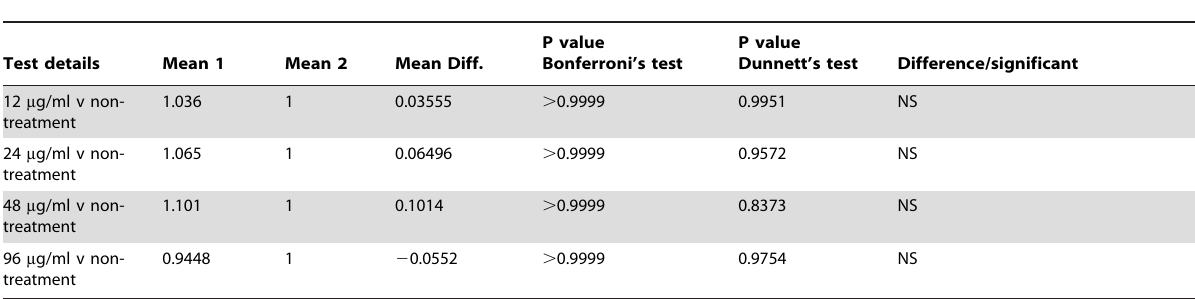
Table 1. Statistical comparisons (ANOVA) for PrP levels in flies treated with 17-DMAG.